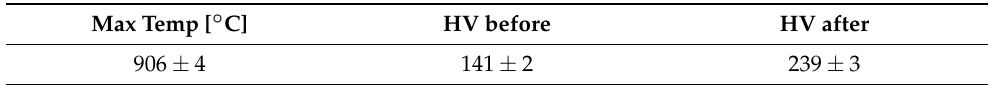
Table 1. Quenching maximum temperature and the Vickers hardness before and after the treatment.